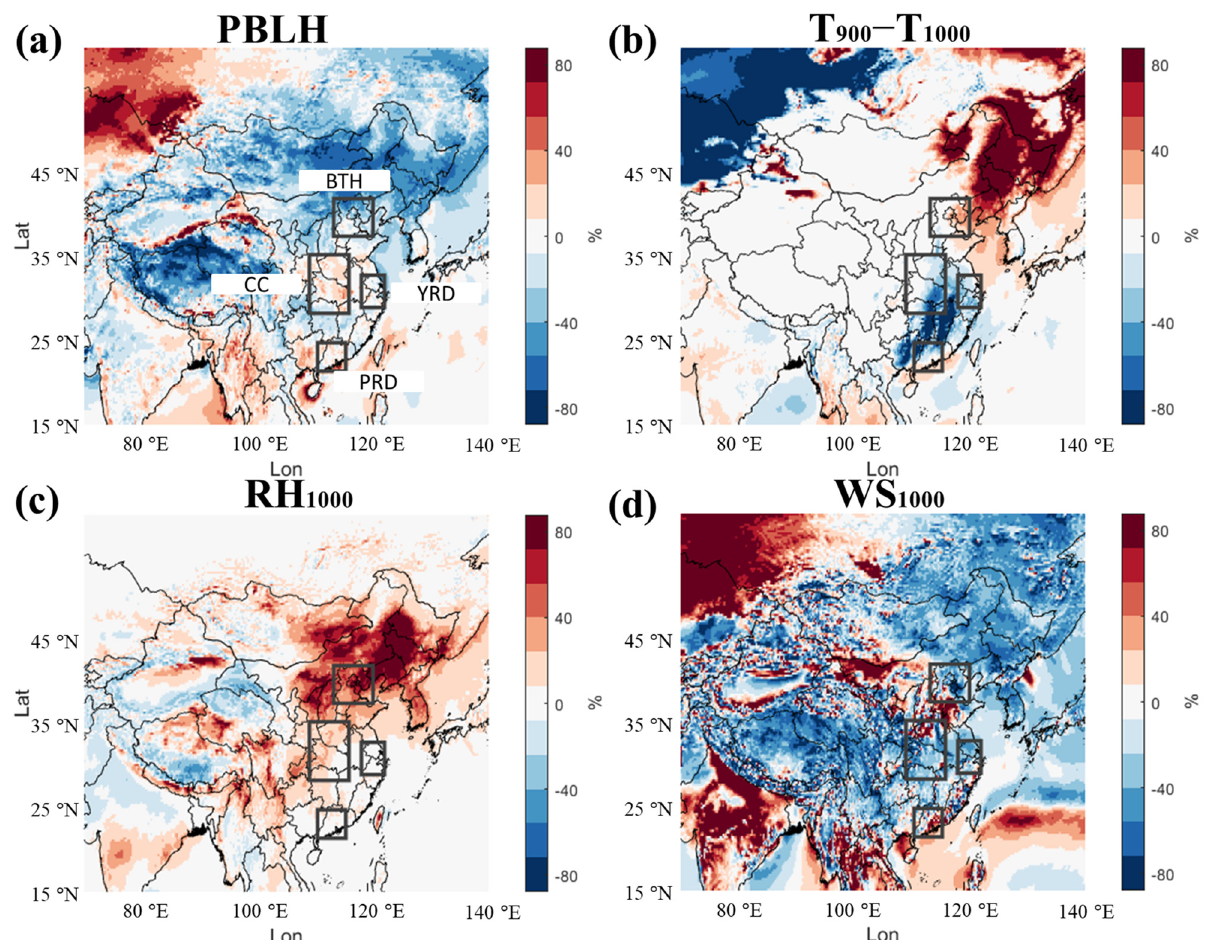
Figure 8. The fractional changes of the meteorological factors between FMC_2020 and FMC_2019 in China. ( a ) PBLH. ( b ) T 900 − T 1000 . ( c ) RH 1000 . ( d ) WS 1000 .